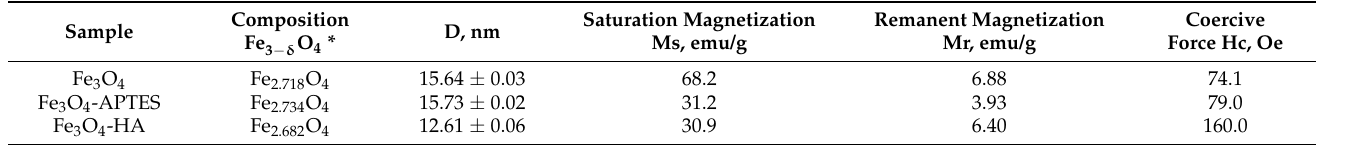
Table 1. Properties of materials according to Mössbauer spectroscopy and Magnetic properties of bare and modified